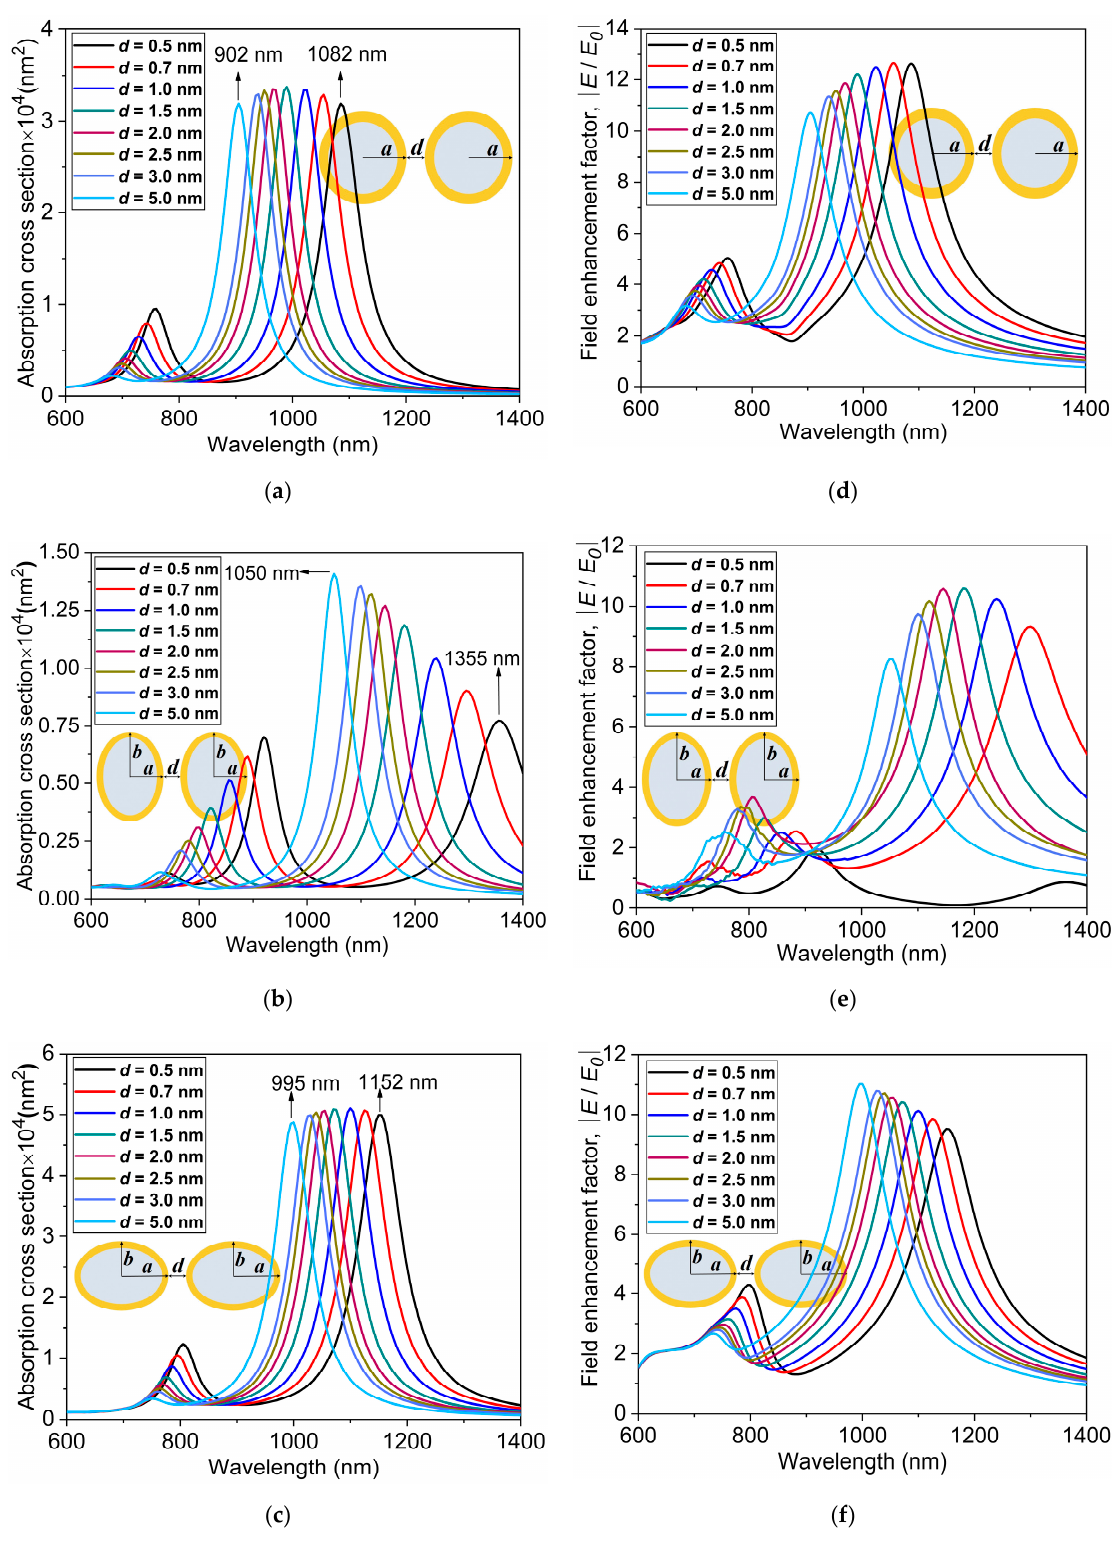
Figure 8. Absorption cross-sections at different distances of separation ( d = 0.5 nm to 5 nm ) for the ( a ) spherical nanostructure ( r = 20 nm, t Au = 3 nm ) , ( b ) prolate, and ( c ) oblate Au core-shell dimer nanostructures ( r eff = 23 nm, η = 3 ) . The electric field enhancement factors, | E / E 0 | , for the ( d ) spherical, ( e ) prolate, and ( f ) oblate